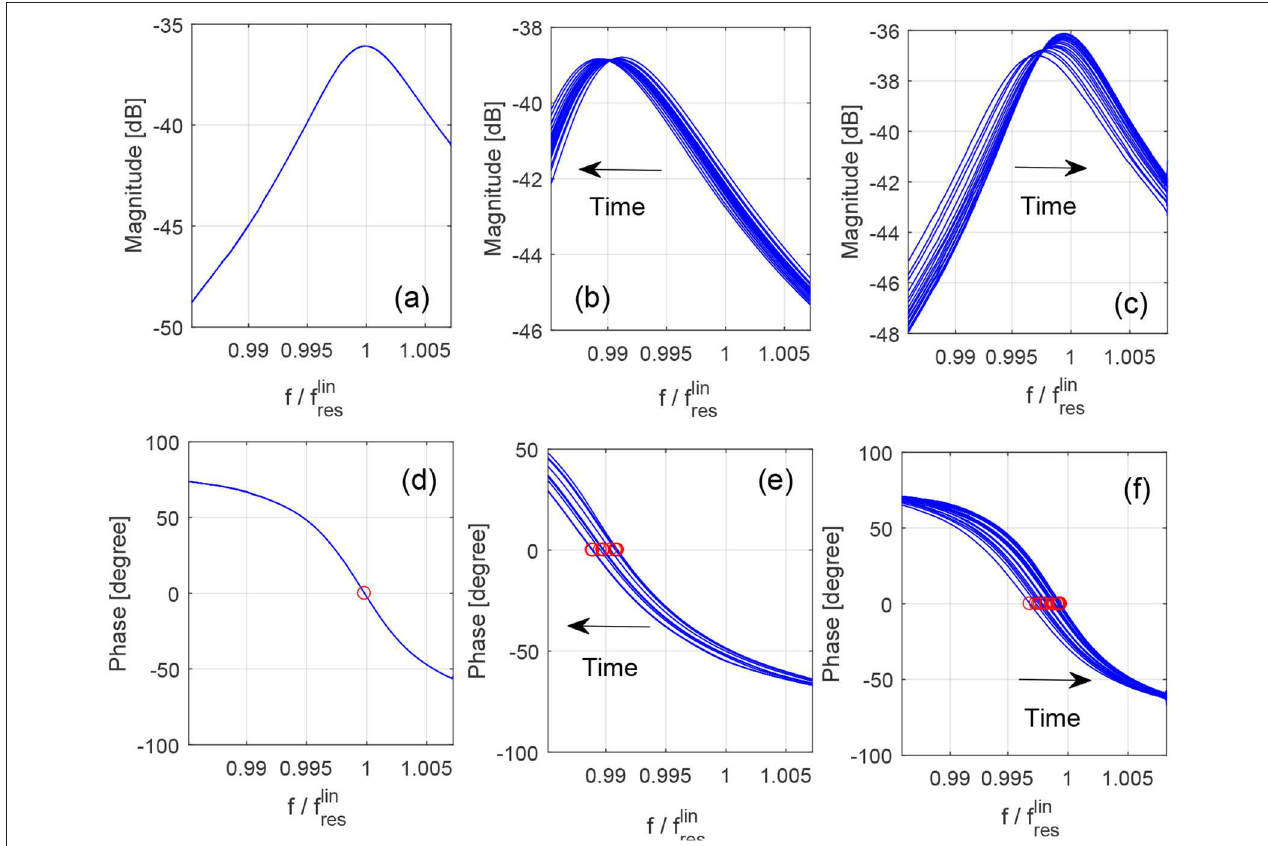
FIGURE 6 | Protocol for slow dynamics measurements for the damaged polymer concrete sample. Preconditioning (a,d) ; Conditioning (b,e) ; relaxation (c,f) . Curves are obtained at successive